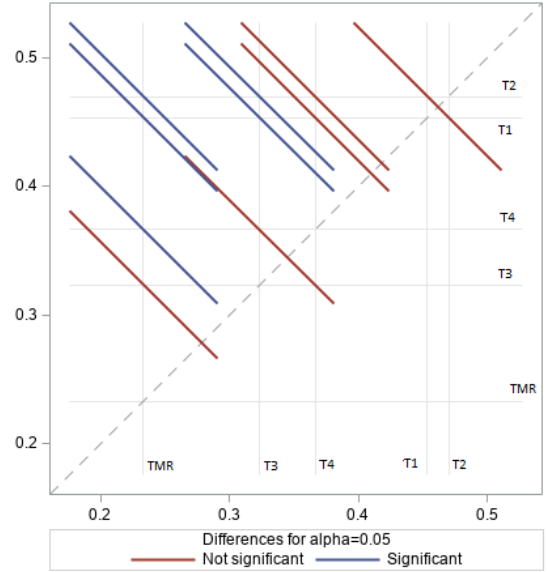
Figure 1. Effect of treatments on α-linoleic acid (ALA %) content of longissimus dorsi (LD) fat muscle in Naemi lambs.